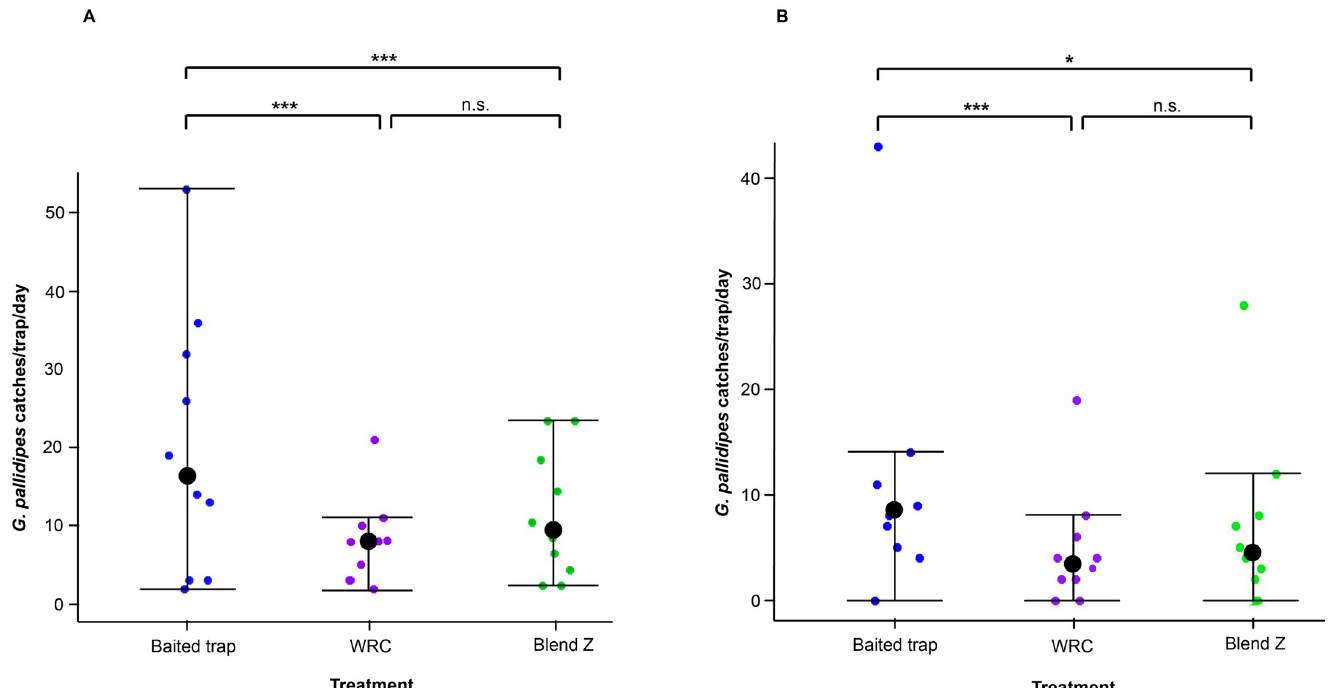
Fig 4. Daily catches of G . pallidipes in baited trap combined with Blend Z in ten replicate trials. Dot plots showing the daily trap catches of G . pallidipes females (A) and males (B). The boundaries of the dot plot whiskers represent the minimum and maximum of all the count data. The dots outside the boundaries are outliers. Black dots represent the median number of catches. Experiment followed a 3 x 3 Latin square design. Baited trap, positive control; WRC, negative control; Blend Z, 7-component blend of EAD-active compounds mimicking zebra skin odor. � = p < 0.05; ��� = p < 0.001; n.s. = no significant difference.